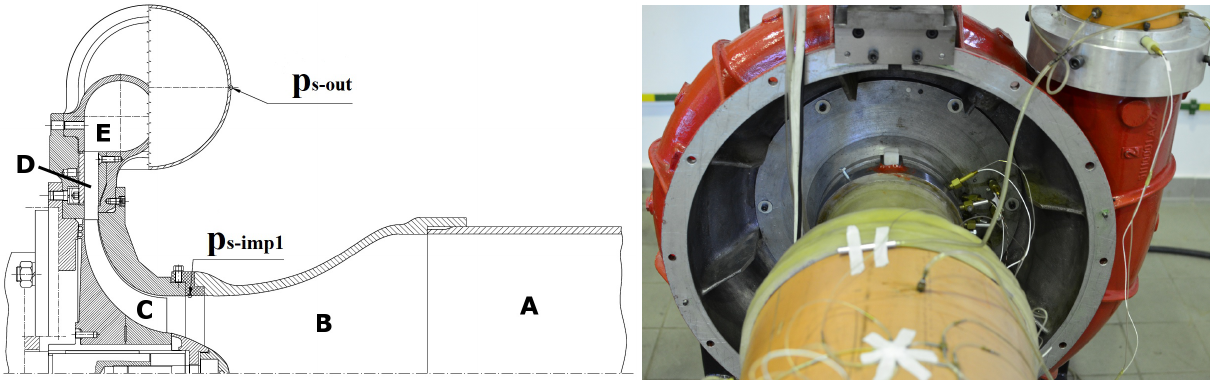
Figure 2. Centrifugal compressor under investigation; cross-section of the machine and photo of the test rig.